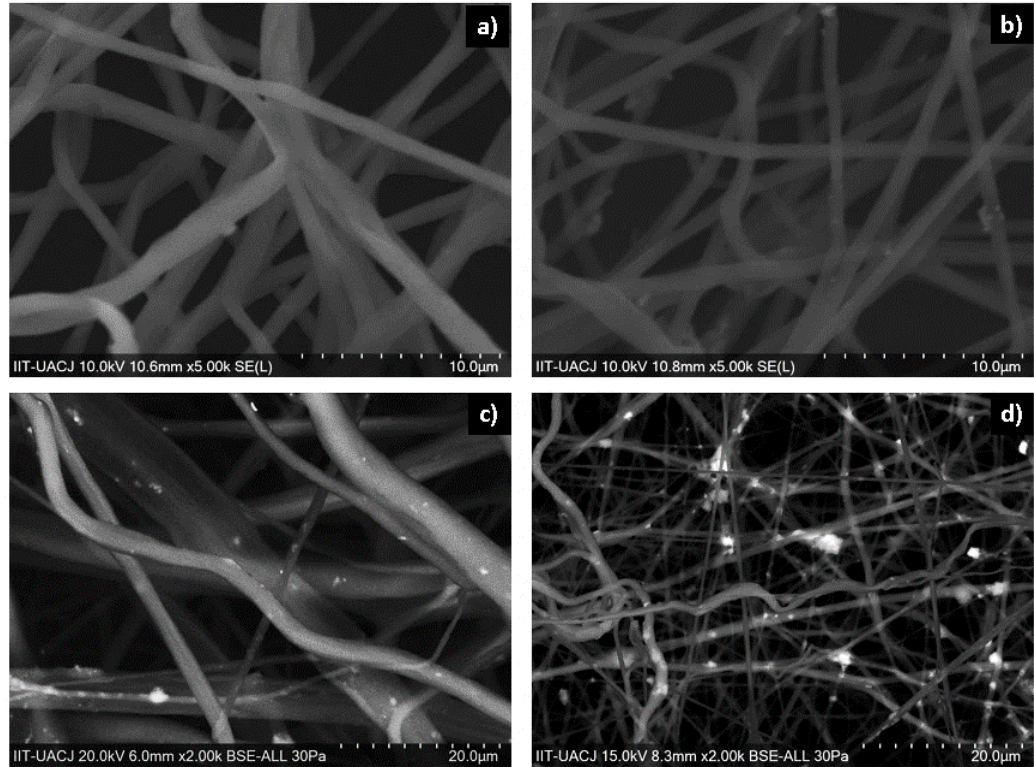
Figure 5. Micrographs obtained by SEM: ( a ) PCL, ( b ) PCL-HA, ( c ) PCL- α -Al 2 O 3 , and ( d ) PCL-HA- α -Al 2 O 3